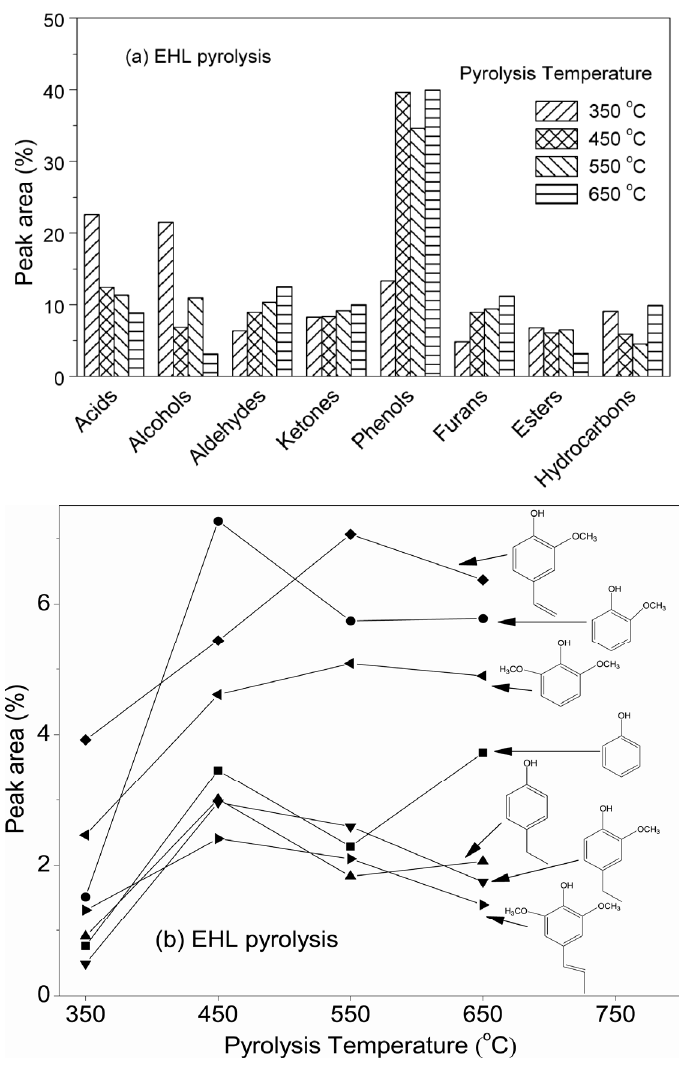
Figure 4. ( a ) Comparison of the product distributions. ( b ) typical compounds from